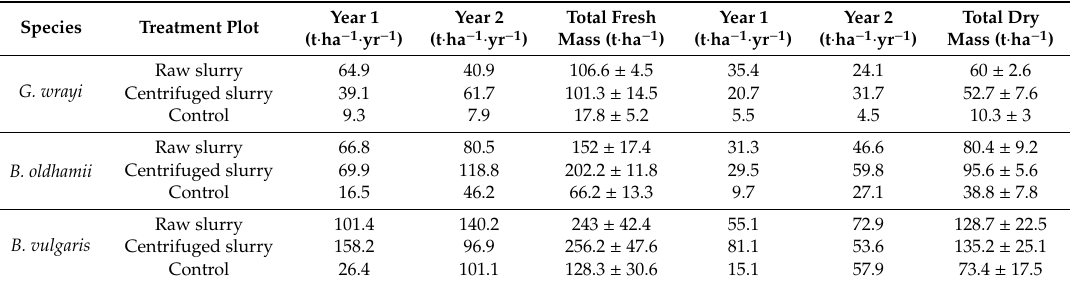
Table 3. Annual aboveground biomass yield, total fresh biomass and total dry biomass at the end of the